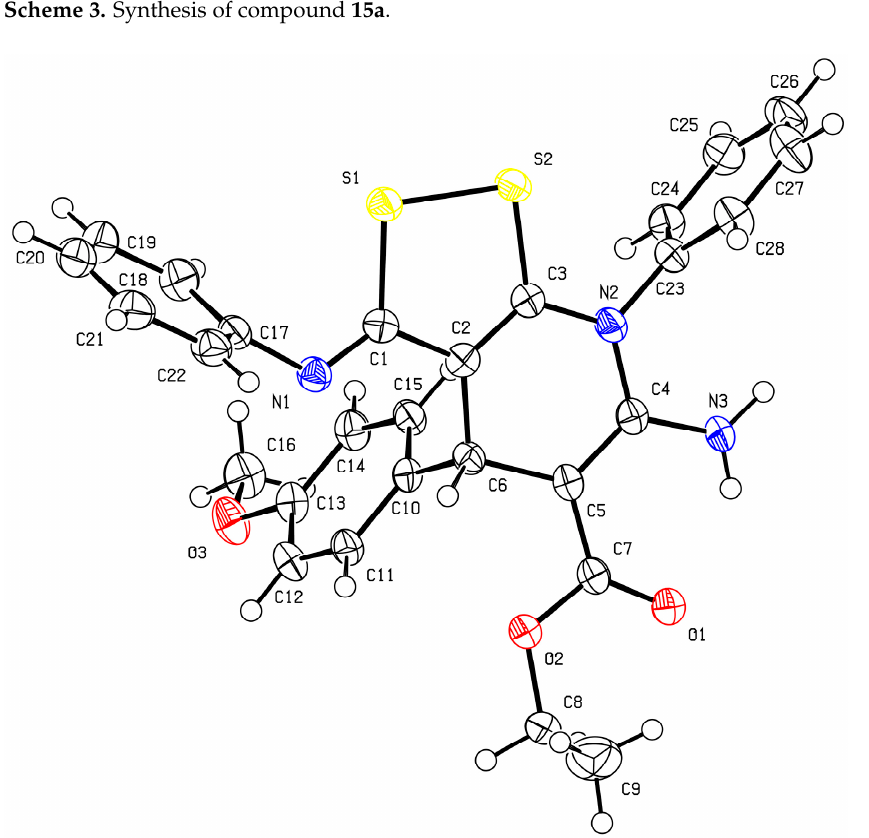
Figure 1. ORTEP drawing of the X ‐ ray structure for ethyl 6 ‐ amino ‐ 4 ‐ (4 ‐ methoxyphenyl) ‐ 7 ‐ phenyl ‐ 3 ‐ (phenylimino) ‐ 4,7 ‐ dihydro ‐ 3H ‐ [1,2]dithiolo[3,4 ‐ b]pyridine ‐ 5 ‐ carboxylate 15a (CCDC deposition number 2219352). Thermal ellipsoids for non ‐ hydrogen atoms are shown at 50% probability. Blue: nitrogen, gray: carbon atoms, red: oxygen atoms, yellow: sulfur atoms.